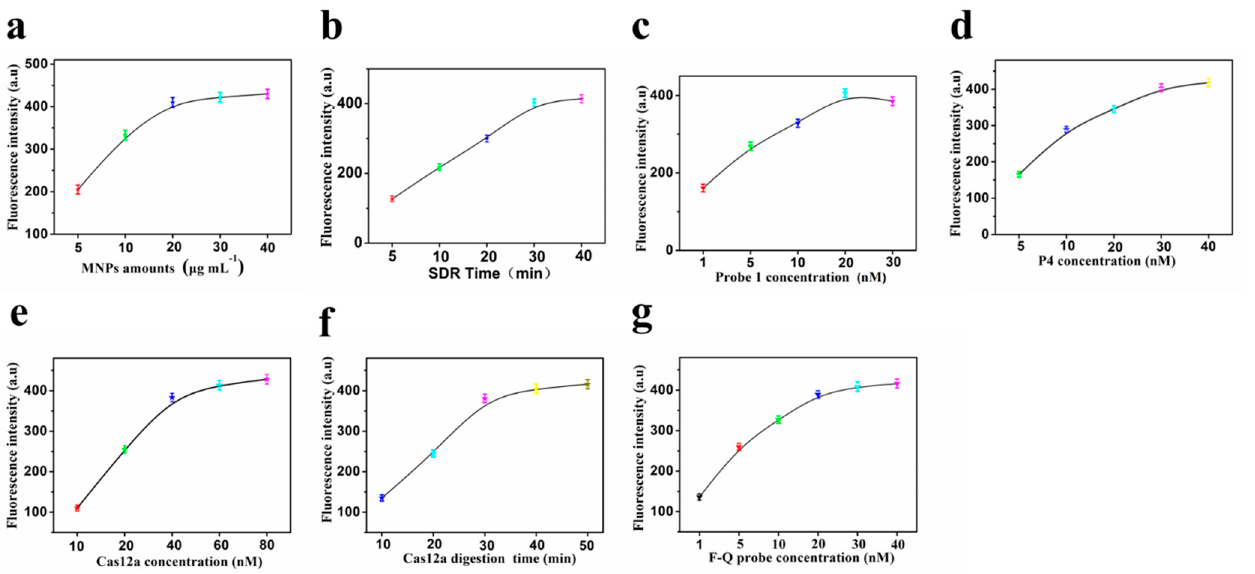
Figure 4. Effects of ( a ) concentration of MNPs; ( b ) reaction time of SDR; ( c ) concentration of P1; ( d ) concentration of P4; ( e ) concentration of Cas12a; ( f ) reaction time of Cas12a; ( g ) concentration of ssDNA-FQ probe. (Error bars: SD, n = 3).